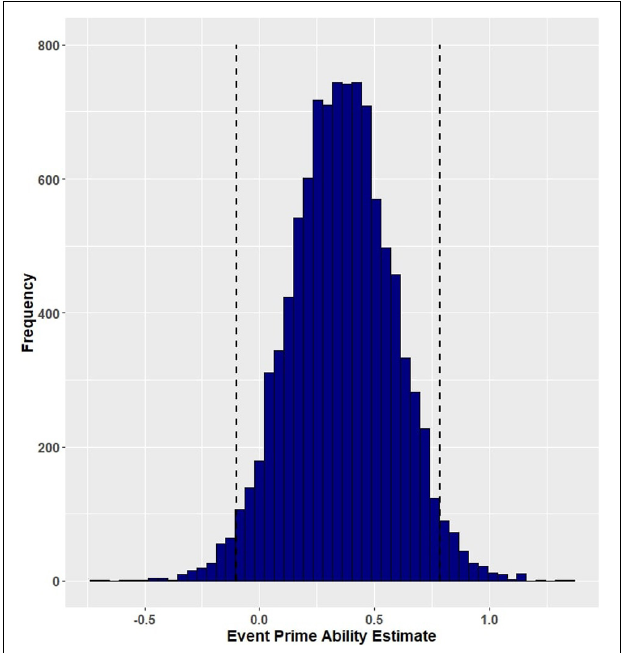
FIGURE 5 | Posterior distribution and 95% highest density intervals (HDIs) of the fixed effect of event-related facilitation from Model 3 (primed accuracy for participants with aphasia). Dashed lines mark the 95% highest density intervals (HDIs) for the posterior distribution.